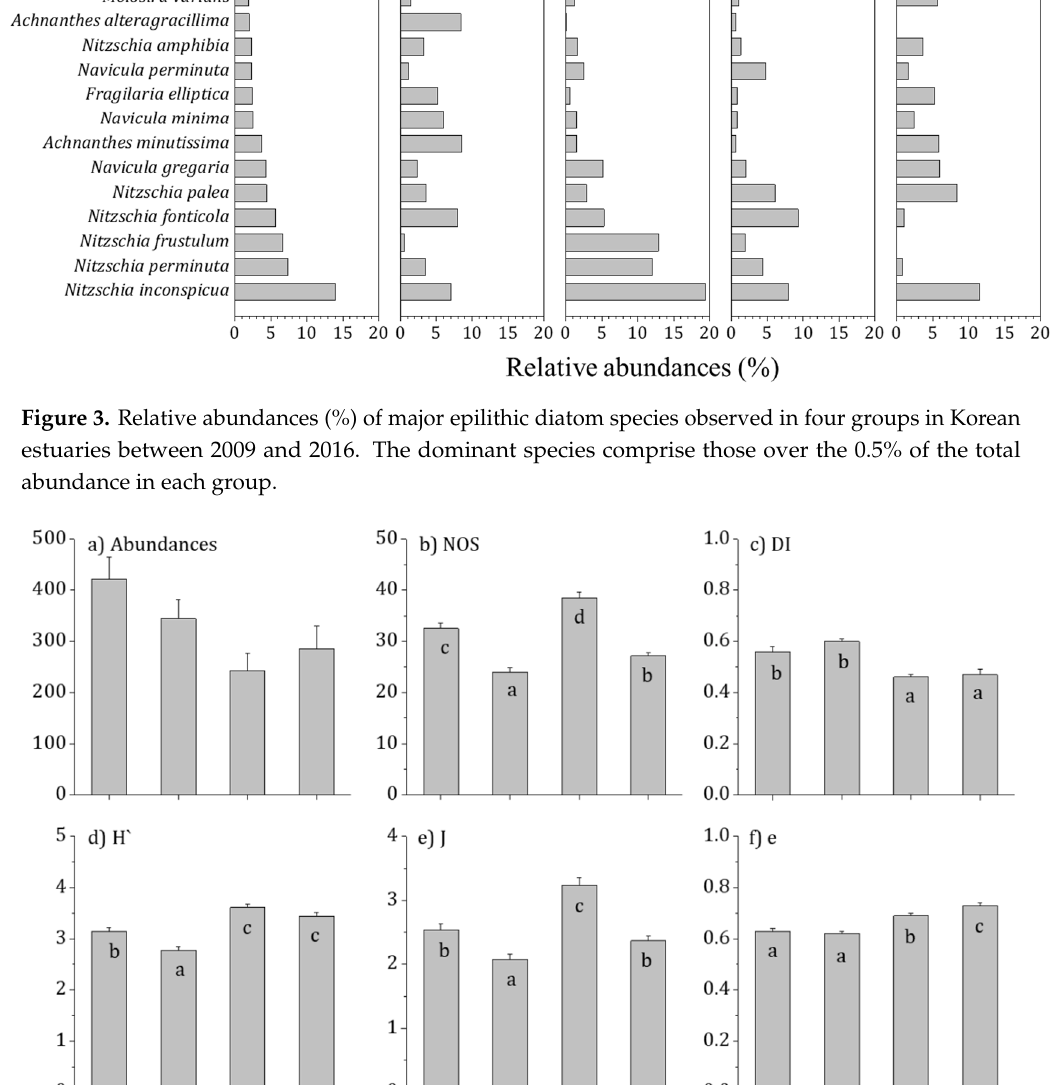
Figure 4. Biological factors in four groups of Korean estuaries between 2009 and 2016. Small letter (a–d) indicate Tukey’s post hoc test with the Bonferroni test: ( a ) abundances (1000 cells / cm 2 ); ( b ) NOS, number of species; ( c ) DI, species dominant index; ( d ) H’, Shannon–Weaver’s diversity index; ( e ) J, richness; and ( f ) e, evenness.